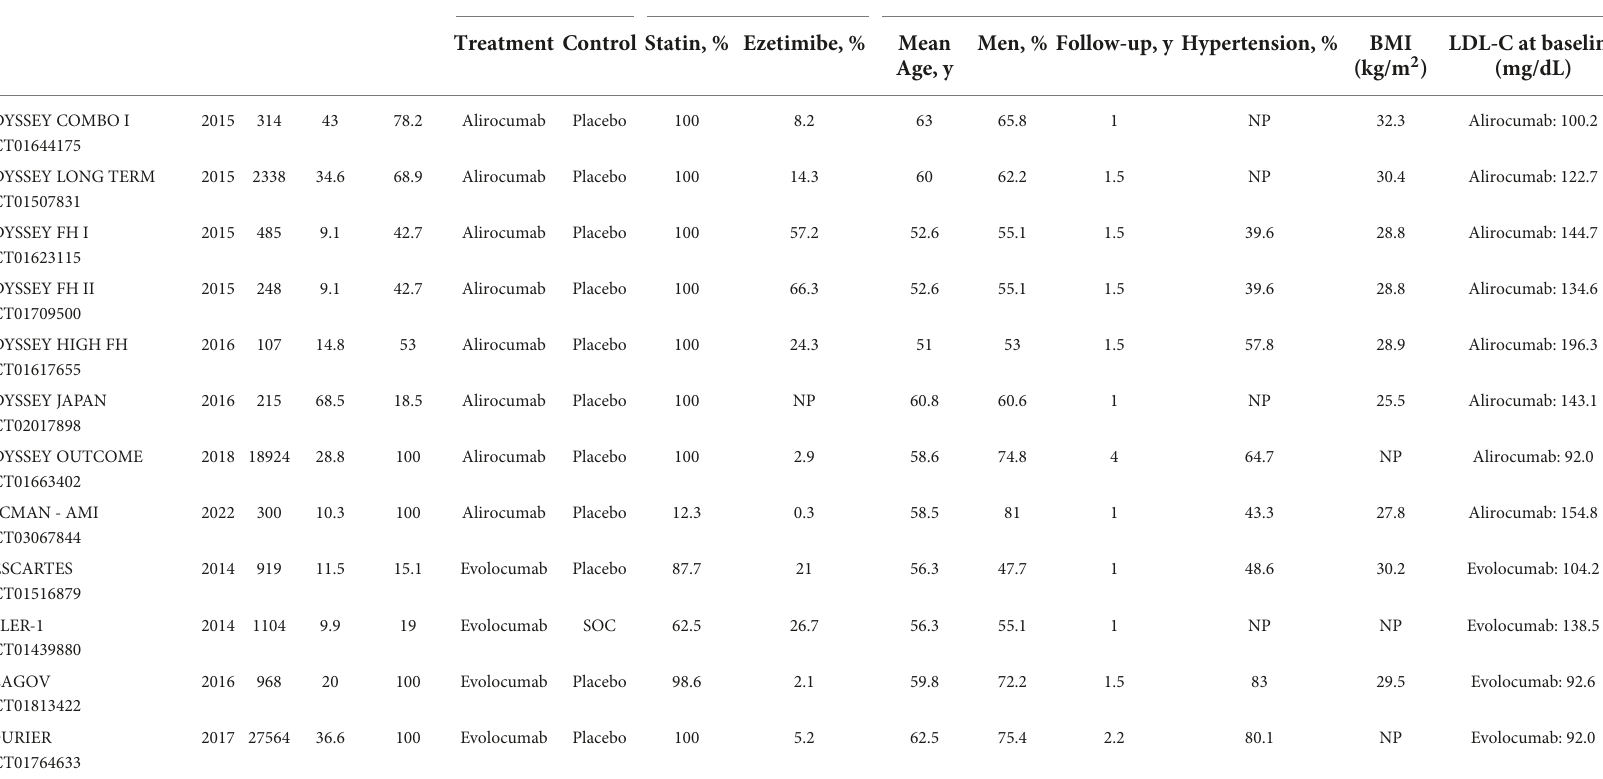
TABLE 1 Characteristics of interventions and populations at baseline included RCT. Study Year n DM, % CAD, % Drugs Background treatment Baseline characteristics Treatment Control Statin, % Ezetimibe,